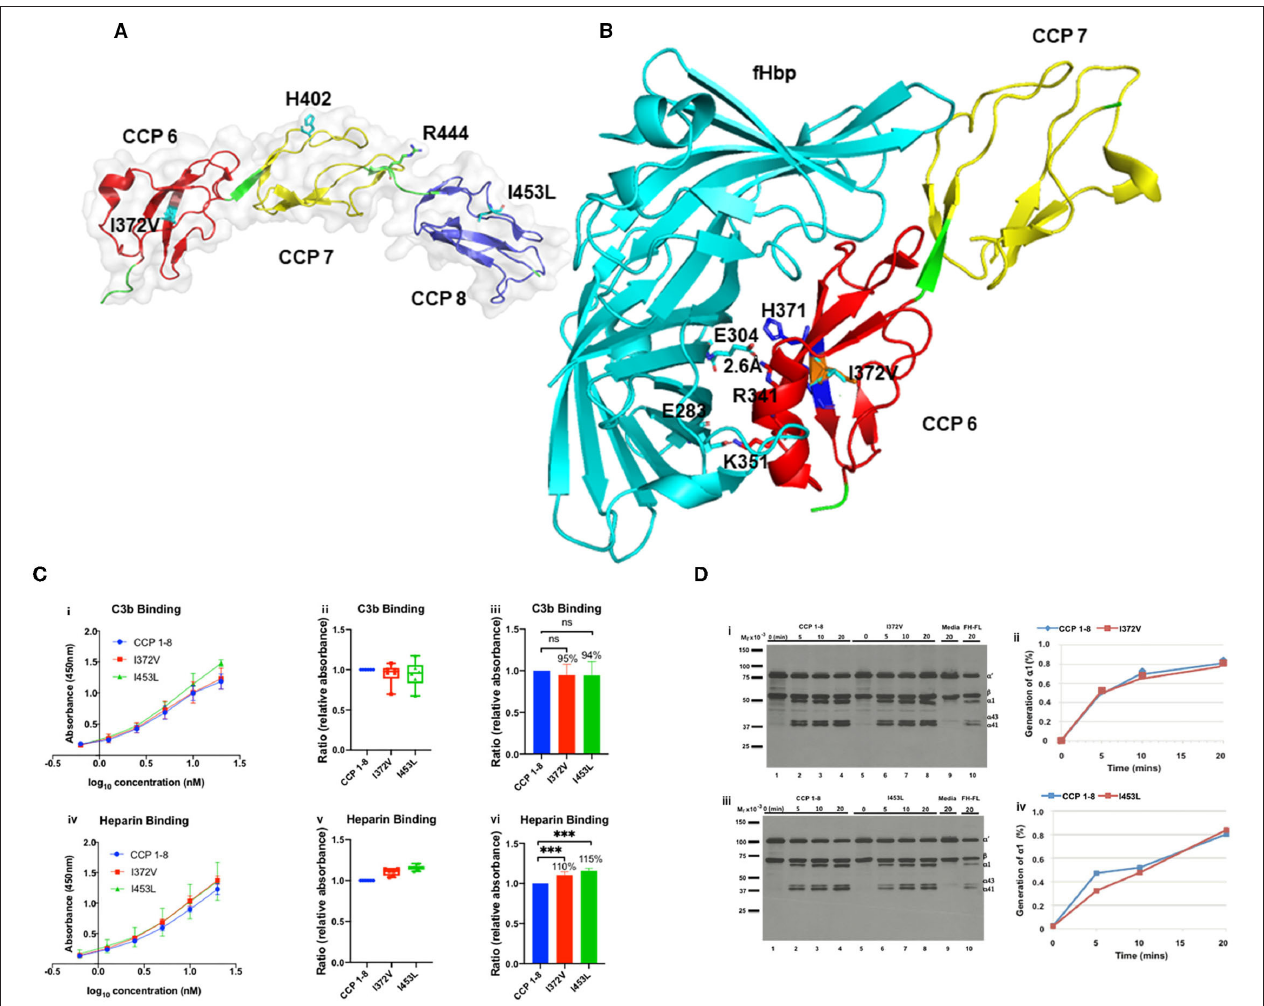
FIGURE 4 | Structural analysis of I372V and I453L (A) The overall structure of FH CCP 6–8 is shown in a cartoon representation (PDBID:2UWN) (20). CCP 6 is in red, CCP 7 in yellow, and CCP 8 in blue. H402 and the two rare variants, I372V and I453L, are in cyan. Crystallographic structural data indicates that CCP 6–8 contain four glycosaminoglycan (GAG) binding sites (20). The primary binding site is H402 (20); the other three putative binding sites are H360 (not shown) in CCP 6, R341 in CCP 6 (in B ), and R444 in CCP 7 (colored green at the linker between CCP 7 and CCP 8). (B) Interface structure of FH CCP 6–7 in complex with FH binding protein (fHbp) derived from Neisseria meningitidis (PDBID: 2W80) ( 21). Side chains from both proteins involved in forming salt bridges across the interaction surface are shown. The putative heparin binding site is composed of H337 (not shown), R341 and H371 in CCP 6 (21). E304 and R341 form a salt bridge over a distance of approximately 2.6Å. E304 and E283 in cyan from fHbP; R341 and K351 from CCP 6 in red; the variant I372V in orange is flanked by H371 and H373 in blue. Structures are prepared using PyMol. Functional analysis of I372V and I453L (C) (i, iv) Absorbance is plotted against logarithmic protein concentrations. (ii, v) Box-and-whisker plots demonstrating C3b and heparin binding (by ELISA) of I372V and I453L compared to WT. Relative absorbance (RA) is computed as absorbance of the variant divided by absorbance of the WT. Bottom of the box shows the 25 th percentile, the line within the box indicates the median, and the top of the box shows the 75 th percentile. (iii, vi) Representation of C3b and heparin binding of I372V and I453L compared to WT using bar graphs. For C3b binding the P -value for the percentage differences of I372V and I453L compared to WT were 0.69 and 0.65, respectively. For heparin binding, the P -value for the percentage differences of I372V and I453L compared to WT were both < 0.001. Data represent three separate experiments with bars corresponding to SEM (standard error of mean). ns, no significant difference; *** P < 0.001. (D) (i, iii) Fluid-phase C3b cofactor activity (CA) of I372V and I453L assessed by the cleavage of purified C3b to iC3b compared to WT. The percentage of alpha chain remaining and the generation of α 1 indicates the cleavage of C3b to iC3b. A kinetic analysis of CA was conducted at 0, 5, 10, and 20min. Cleavage rate is measured by densitometric analysis of the generation of α 1 relative to the β chain. Representative Western blot is shown. (ii, iv) Densitometric quantification of the Western blot. Lane 9 represents a negative control employing concentrated supernatant in the presence of FI but absence of FH. Lane 10 is a positive control using full-length FH (FH-FL). Upon comparison to WT FH, there is no difference in CA of I372V and